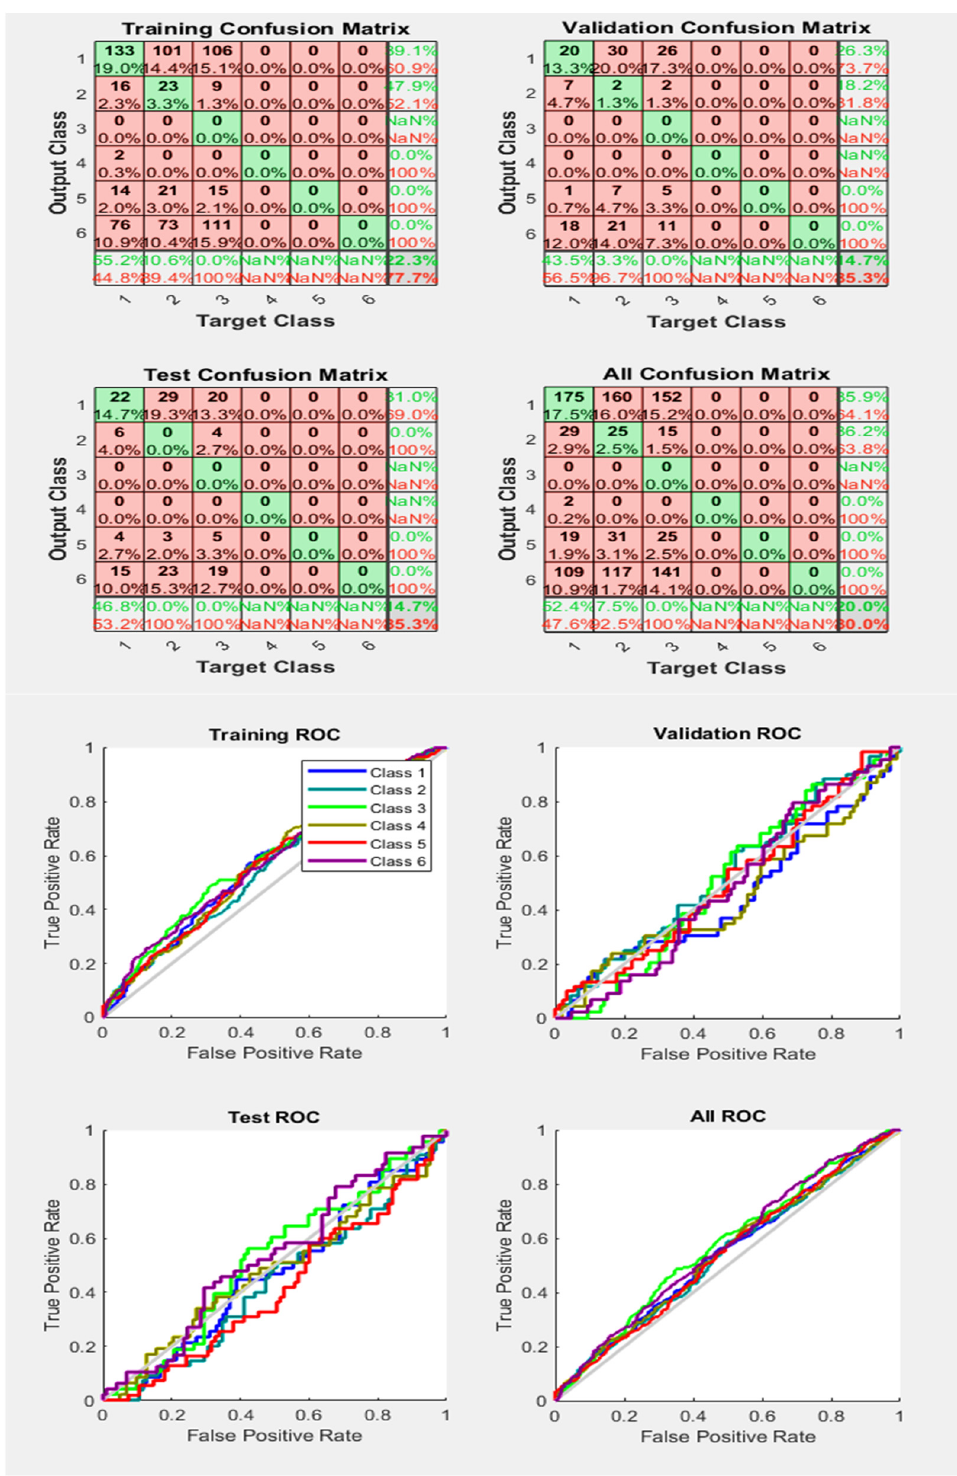
Figure 19. Neural Network Model ROC (Receiver Operating Characteristics) and Confusion Matrix for LM TrainFcn/Activation Function at level 9 (RMS) Features for High Contact Resistance Fault with 80.0% Accuracy. Grey line shows diagonal of the ROC for indicating Class 1–6 lines are lying above or below or on it.